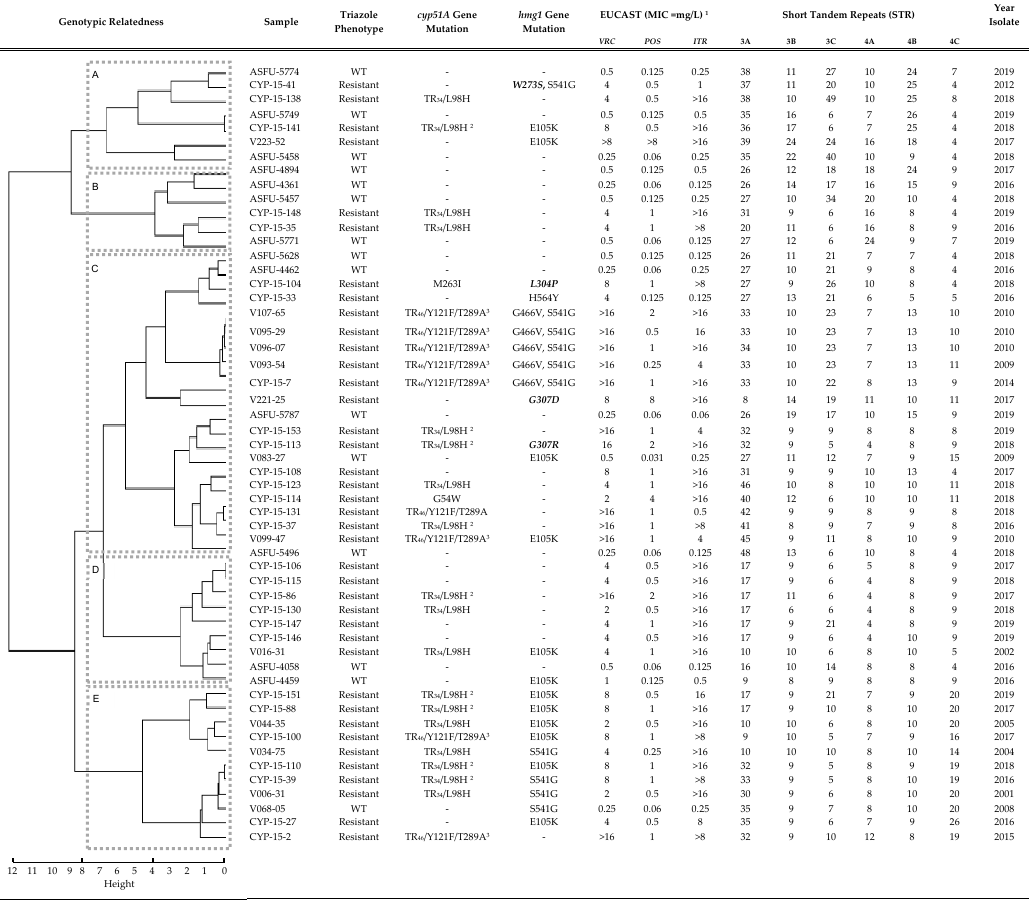
Figure 2. Characteristics and Genetic Relatedness of Aspergillus fumigatus Clinical Isolates Harboring hmg1 Gene Mutations and of Selected Isolates without hmg1 Gene Mutations. 1 EUCAST broth microdilution reference method for filamentous fungi. 2 Atypical TR 34 / L98H (elevated) MIC values: itraconazole ≥ 4, voriconazole ≥ 8, posaconazole ≥ 0.5 mg / L. 3 Atypical TR 46 / Y121F / T289A phenotype (elevated) MIC values: voriconazole ≥ 4, itraconazole ≥ 4, posaconazole ≥ 0.25 mg / L. Amino-acid variances located in the sterol-sensing domain (SSD) are depicted in bold and Italic (SSD, 242-415, genome AFUB_020770). Abbreviations: MIC (Minimal inhibitory concentration), VRC (voriconazole), POS (posaconazole), ITR (itraconazole). Not detected =